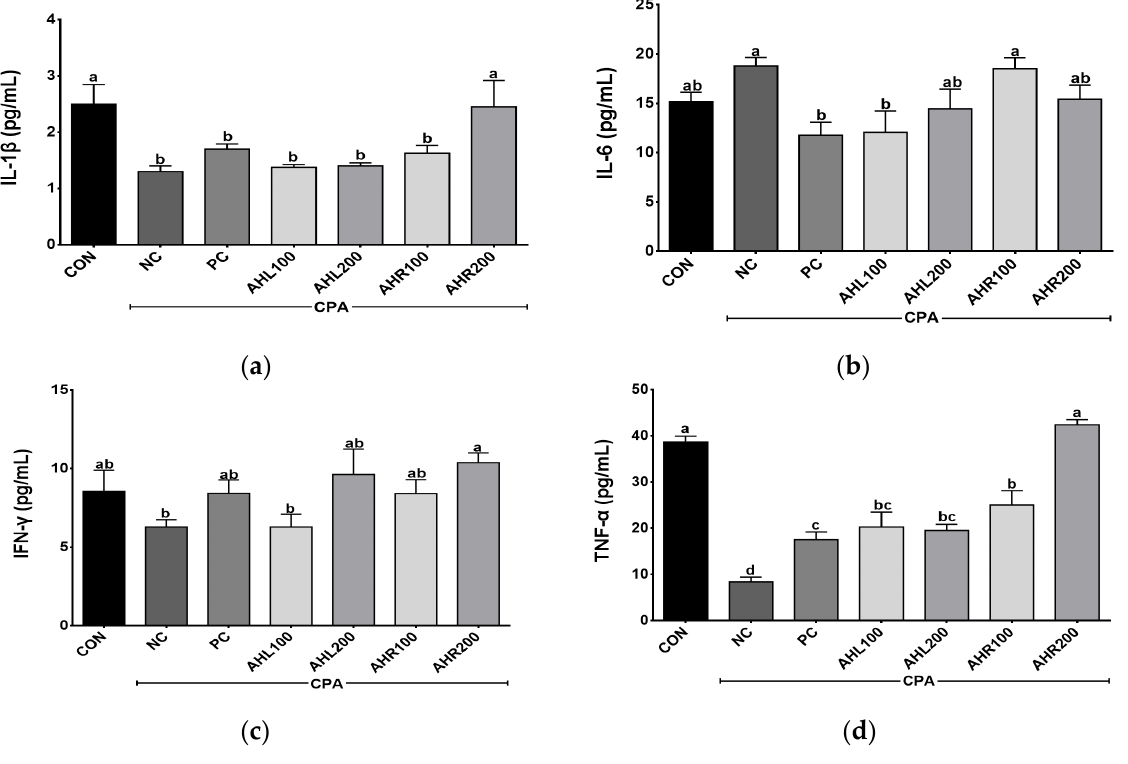
Figure 7. Effects of A. hookeri leaves (AHL) and A. hookeri roots (AHR) extracts on serum ( a ) IL-1 β , ( b ) IL-6, ( c ) IFN- γ , and ( d ) TNF- α levels of C57BL/6 mice immunosuppressed by CPA. CON, normal control group; NC, negative control group; PC, positive control group; AHL100, AHL extract 100 mg/kg BW; AHL200, AHL extract 200 mg/kg BW; AHR100, AHR extract 100 mg/kg BW; AHR200, AHR extract 200 mg/kg BW. Data was presented as the mean ± SEM (n = 12). a–d Different letters are significantly different at p < 0.05.